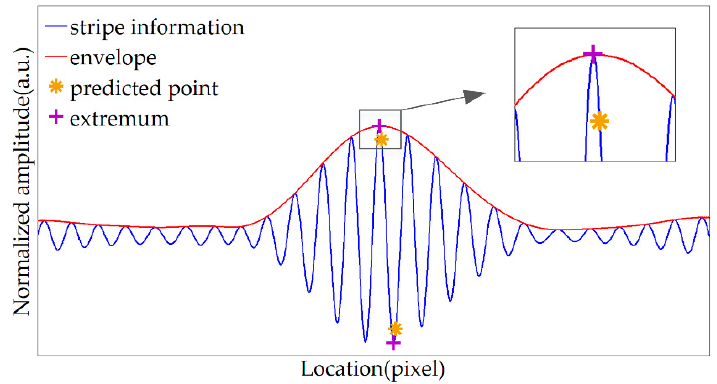
Figure 12. Determine the extremum locations of the target order fringe.